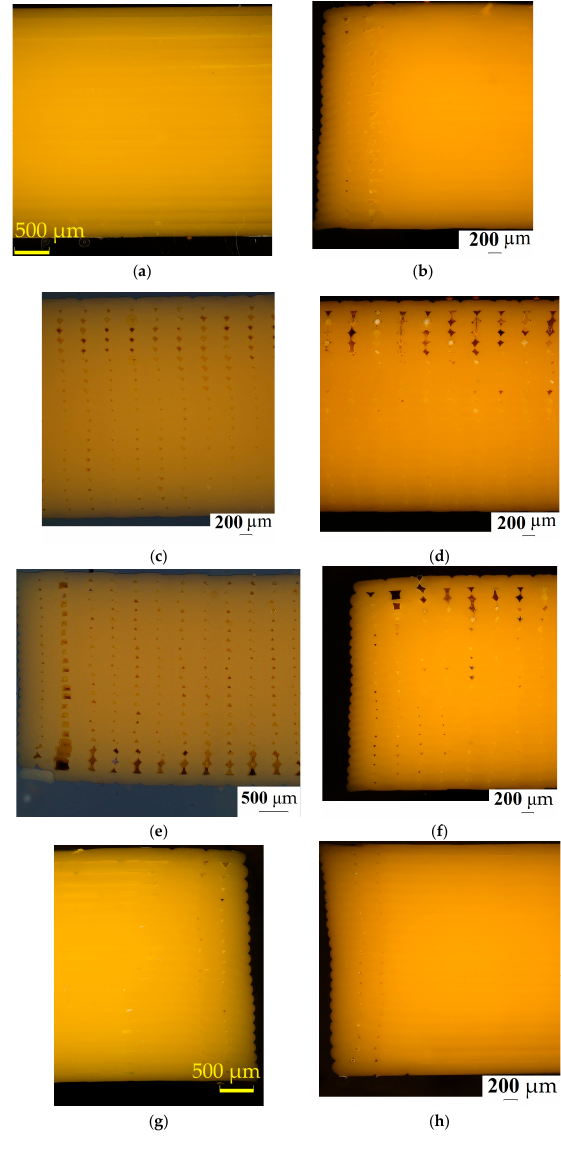
Figure 11. The microscopy tests of the printed and heat-treated specimens. ( a ) The vertically printed specimen cut parallel to the printing orientation; ( b ) the vertically printed specimen cut parallel to the printing orientation, after heat treatment at 65 °C; ( c ) the vertically printed specimen cut per- pendicular to the printing orientation. ( d ) The vertically printed specimen cut perpendicular to the printing orientation, after heat treatment at 65 °C; ( e ) the horizontally printed specimen cut perpen- dicular to the printing orientation; ( f ) the horizontally printed specimen cut perpendicular to the printing orientation, after heat treatment at 65 °C; ( g ) the horizontally printed specimen cut parallel to the printing orientation; ( h ) the horizontally printed specimen cut parallel to the printing orien- tation, after heat treatment at 65 °C.